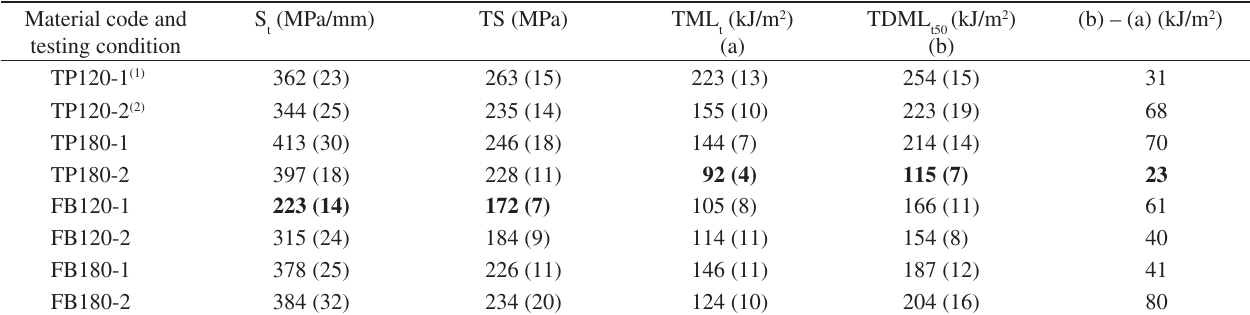
Table 1. Résumé of tensile tests results for as-received (virgin) carbon-epoxy composite laminates. Standard deviation is provided in parenthesis. Material code and testing